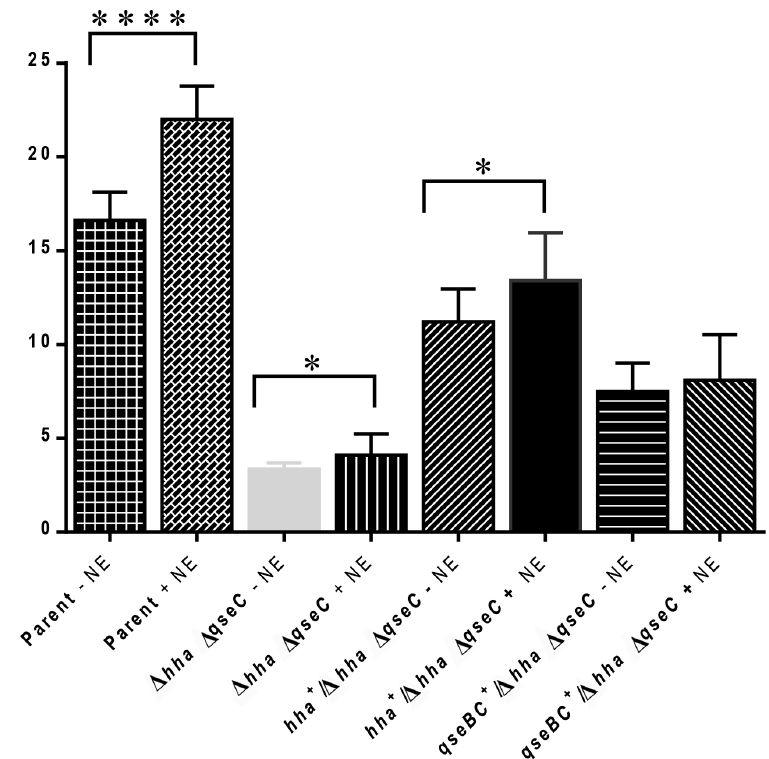
Figure 3. Relative contributions of hha and qseC to the regulation of motility. Relative motility of a hha qseC double deletion mutant was compared to the same mutant complemented with a plasmid-cloned copy of hha or qseC on the soft-agar motility plates lacking or supplemented with norepinephrine (NE). The motility zones produced after an overnight incubation at 37 u C are shown as bar graphs. The bars represent mean diameters of the motility zones (mm) 6 SEM computed from the three independent bacterial cultures of each strain. Significance of the difference in motility of a strain grown on a soft-agar motility medium lacking or containing NE is shown by asterisks above the brackets. * ( p =0.05); **** ( p= , 0.0001).